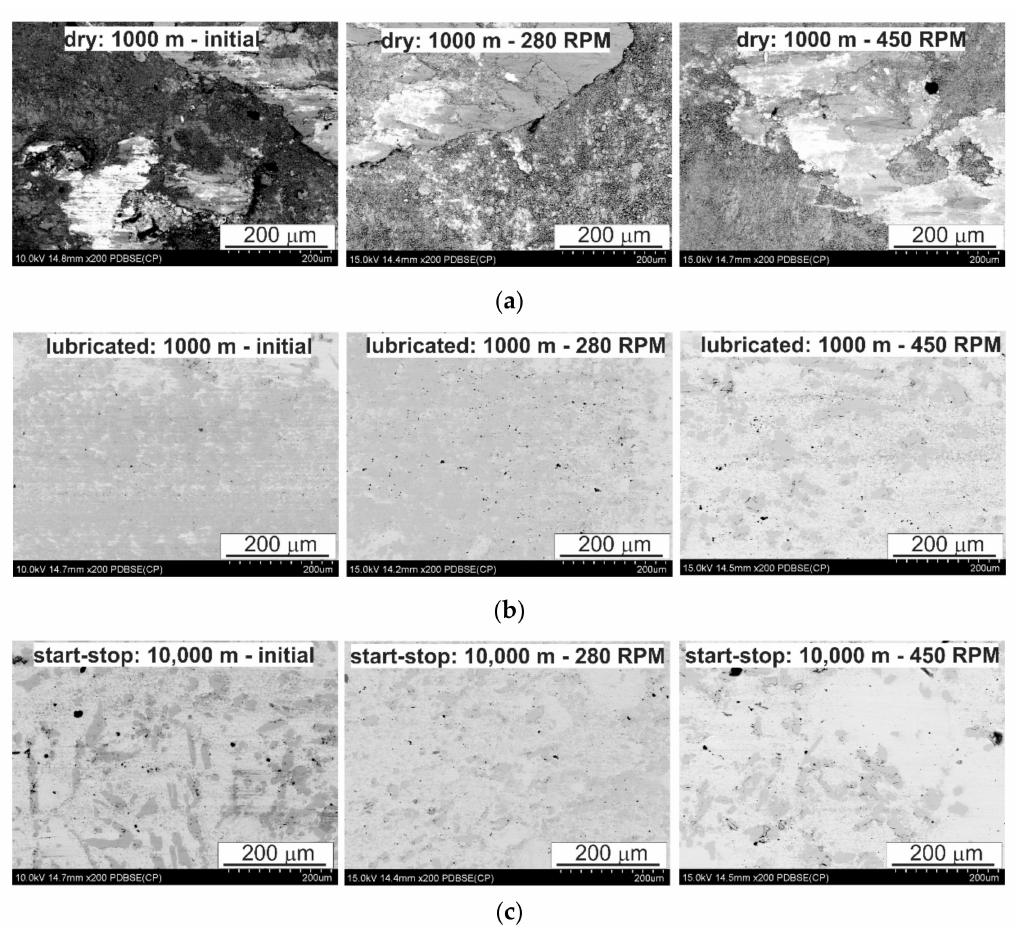
Figure11. CharacteristicsamplesurfaceofSnSb11Cu6alloyaftertribologicaltestsindi ff erentconditions;